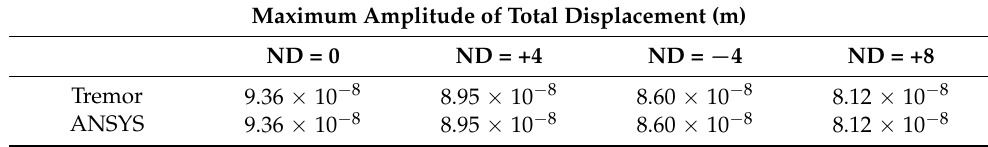
Table 1. Tremor–ANSYS comparison (1st family, case